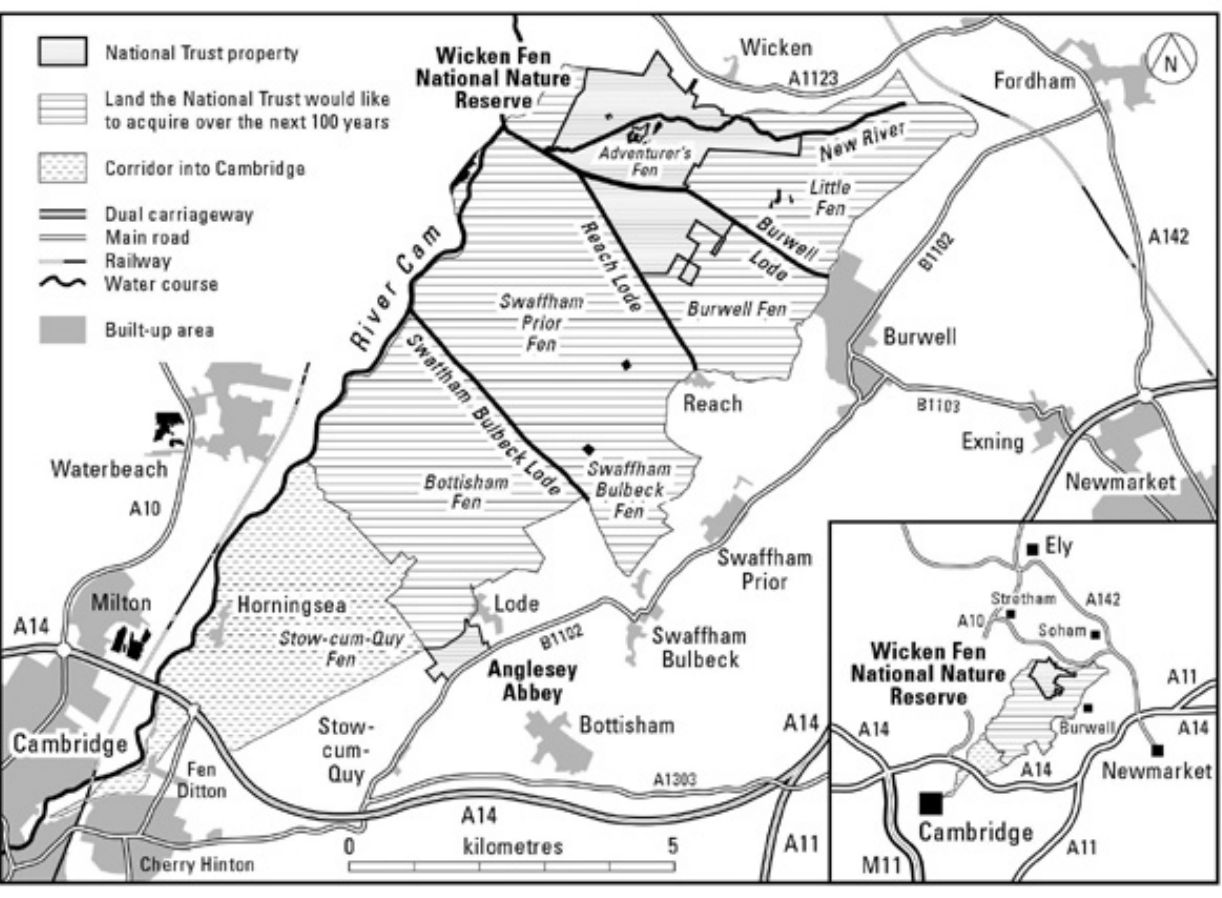
Fig. 8. A map of the 'Wicken Fen 100 Year Vision" area with the National Nature Reserve and restoration area